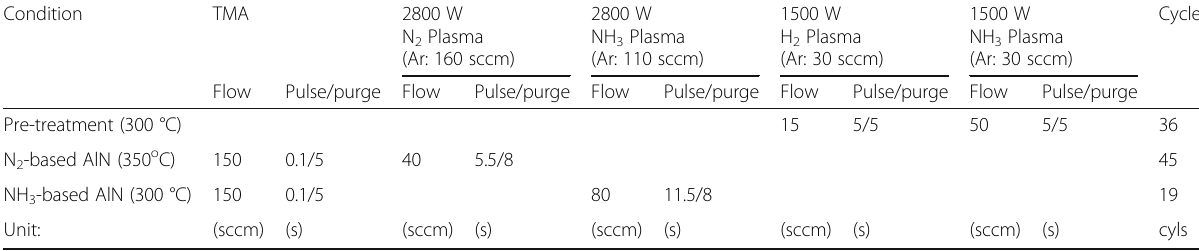
Table 1 Surface treatment and high- κ dielectric growth condition by PEALD Condition